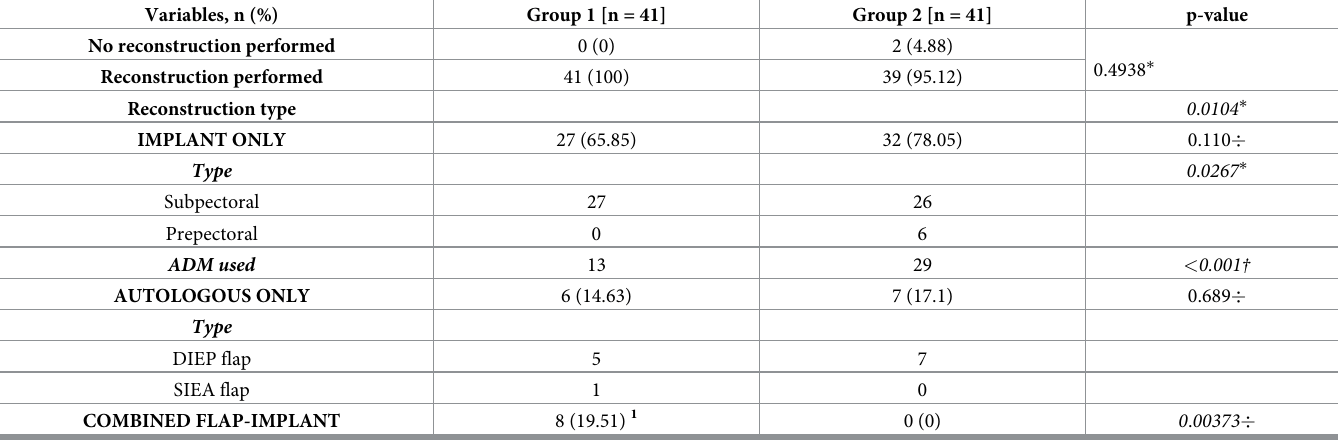
Table 3. Reconstructive surgery data in patients undergoing BRRM over the entire study period. Variables, n (%)